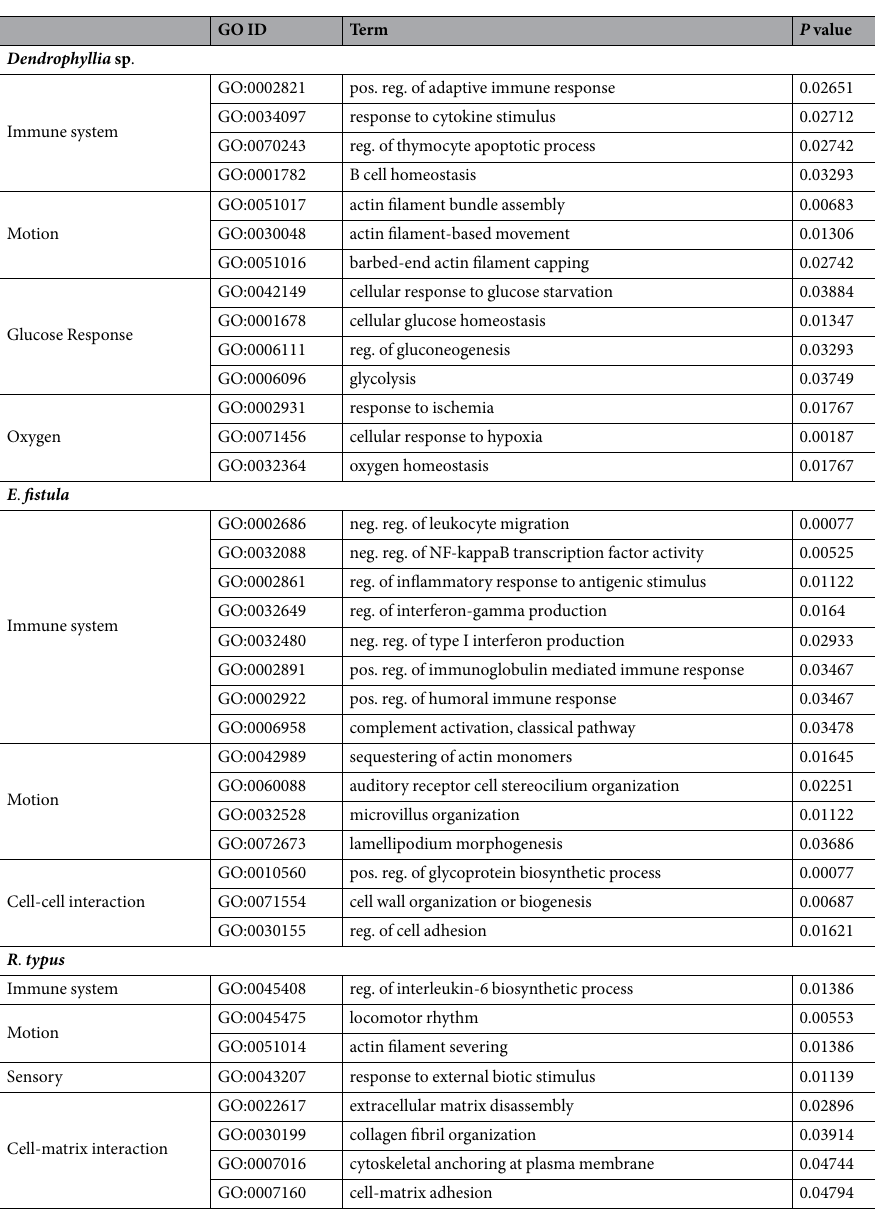
Table 2. Significantly enriched GO terms for highly expressed genes (FPKM > 100) for three deep-sea coral species from the Red Sea ( P value < 0.05), manually sorted into higher order